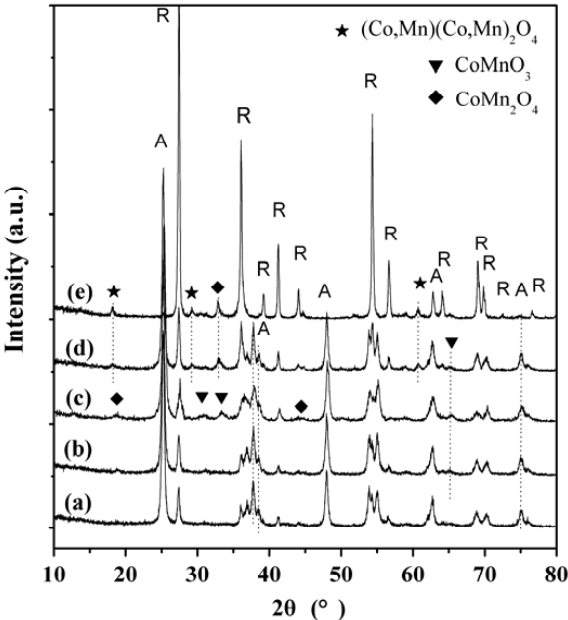
Figure 4. XRD patterns of the 10Mn ‐ 5Co/TiO 2 catalysts calcined at various temperatures: ( a ) 573 K; ( b ) 673 K; ( c ) 773 K; ( d ) 873 K; and ( e ) 973 K. (A = anatase phase of TiO 2 , R = rutile phase of TiO 2 ).